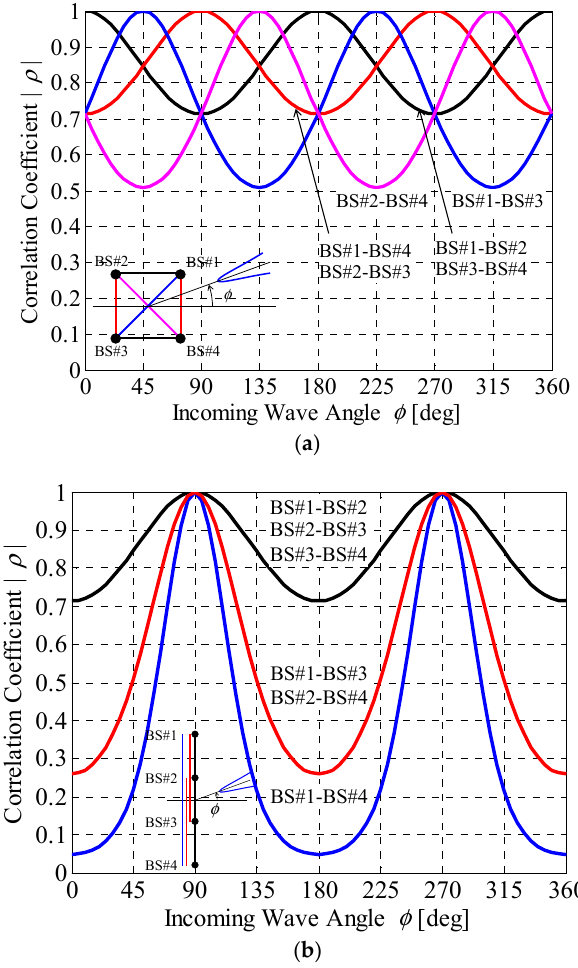
Figure 10. BS Correlation characteristics vs. incoming wave angle: ( a ) circular array; ( b ) linear array.